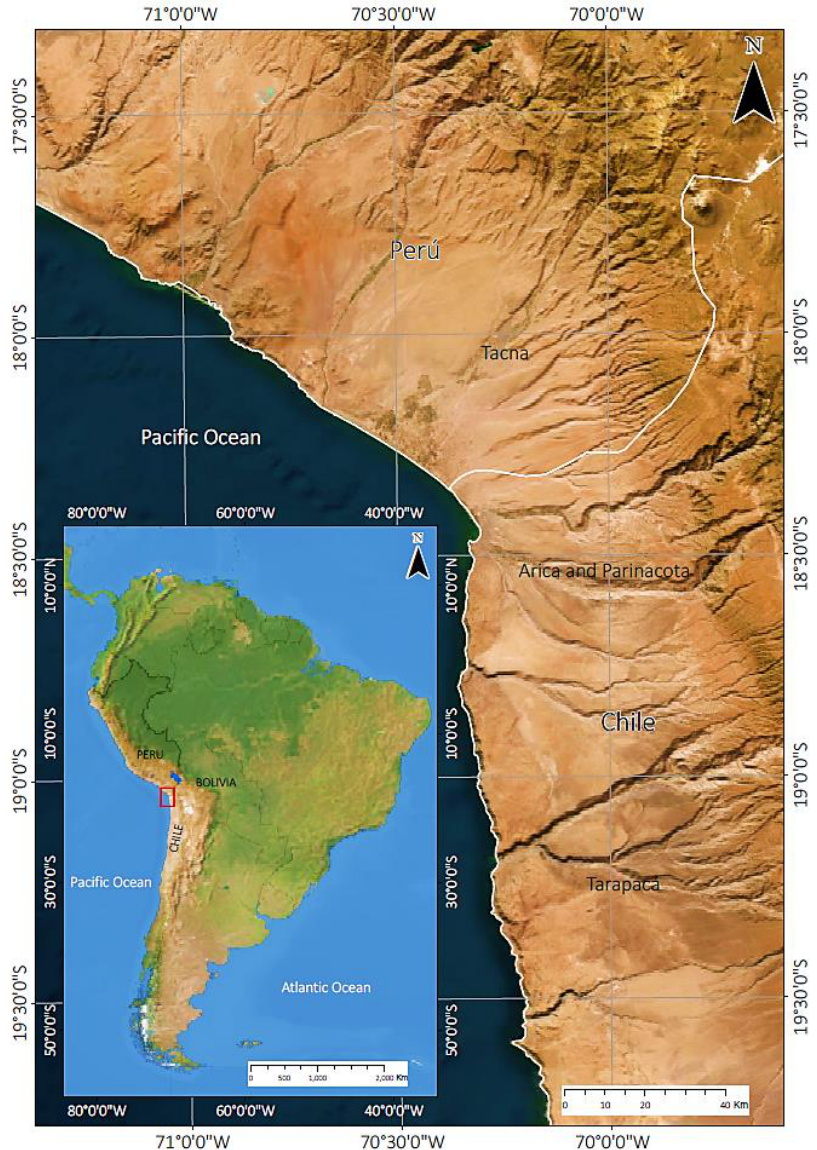
Figure 2. Location of the study area.